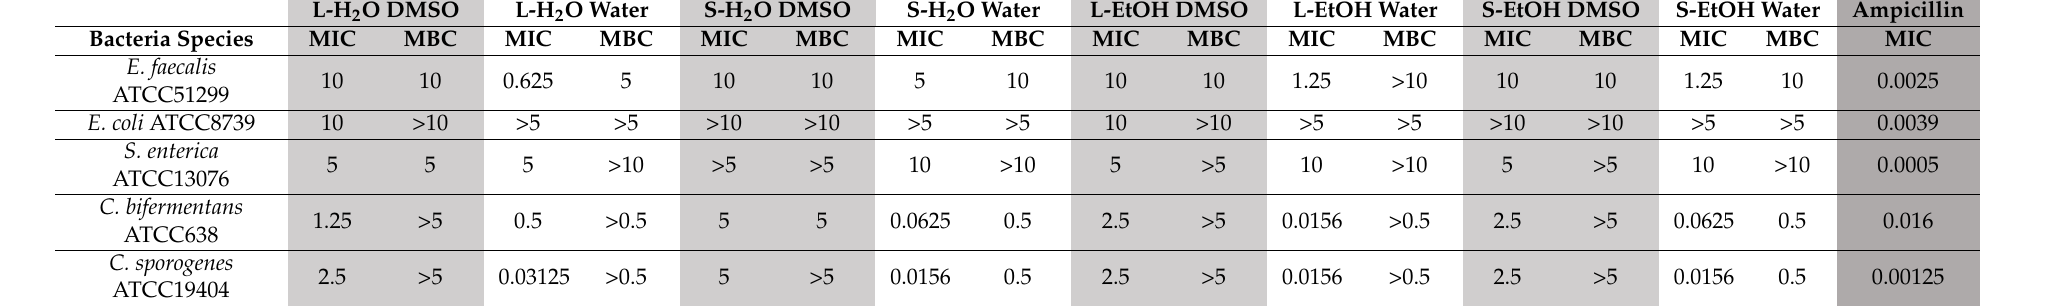
Table 2. Antibacterial activity of the extracts from Rubus caesius [mg/mL], dissolved in water or DMSO, expressed as MIC and MBC.